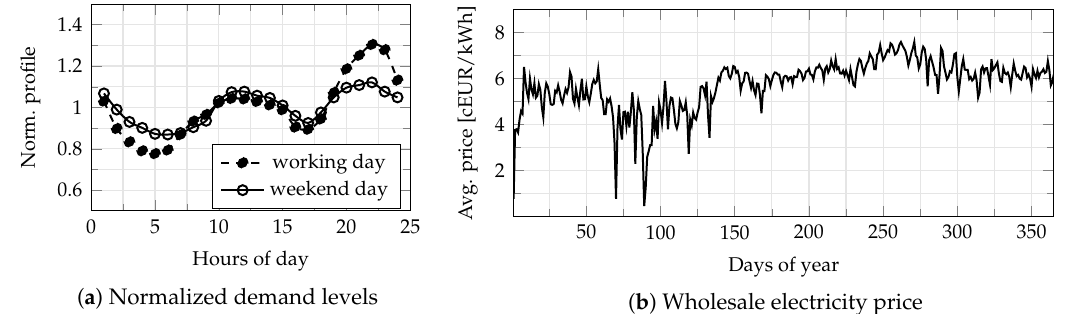
Figure 7. Estimated averaged and normalized price profiles for working and weekend days ( a ) and reported average daily prices ( b ) for the Spain wholesale electric energy market in